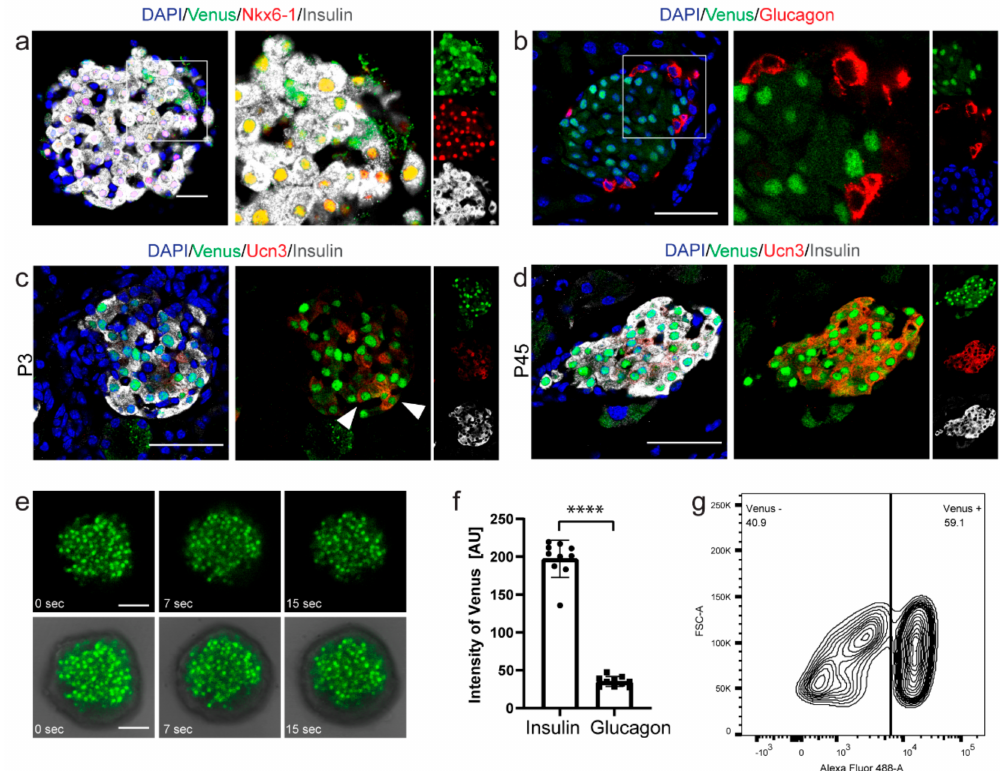
Figure 4. Nkx6-1-VF adult mice express Venus in the mature islets and can be used to sort β -cells in vivo. ( a ) Co-staining of GFP and Nkx6-1 on heterozygous adult pancreatic islets shows co-localization of both markers in insulin-producing cells ( b , f ) but no expression in glucagon-secreting cells. ( c , d ) Immunostaining of P3 and P45 pancreatic sections showing the maturation of Nkx6-1-VF β -cells. ( c ) At P3, only a fraction (white arrowheads) of the reporter cells express Ucn3, ( d ) while all the reporter cells express this maturation marker at P45. Scale bar 50 µ m. ( e ) Time-lapse imaging of isolated islets from adult Nkx6-1-VF mice. Scale bar 50 µ m. ( g ) Representative FACS-plot indicating the successful separation of endocrine cells from the isolated adult islets based on the Venus fluorescent signal. *** p < 0.0001; t